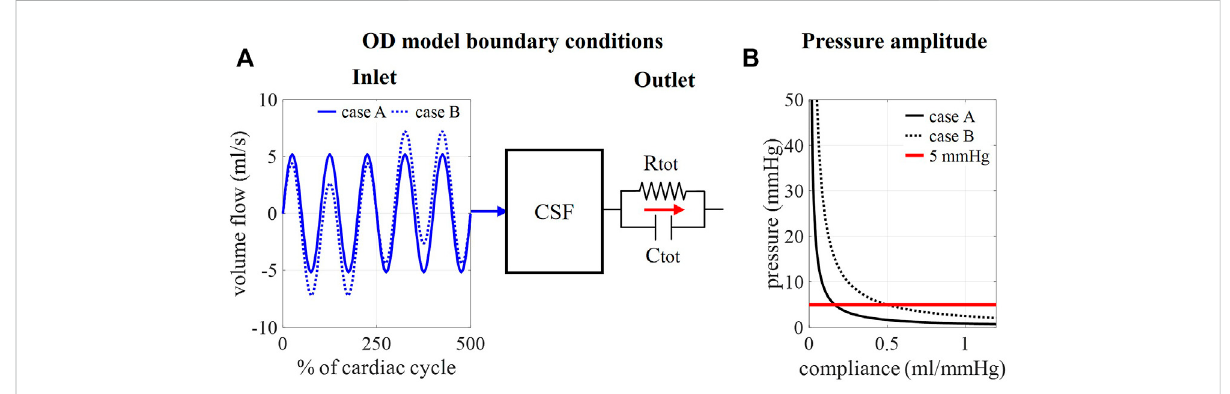
FIGURE 2 (A) Schematic of the 0D model assuming one inlet and one 2-element windkessel outlet. (B) Fitting compliance values for cases A and B using the0Dmodel.Pressurepulsationamplitudesfor1,000compliancevaluesrangingfrom0to1.2 ml/mmHg(blackcurves)arevisualizedtogetherwith the targeted amplitude of 5 mmHg (red curve).